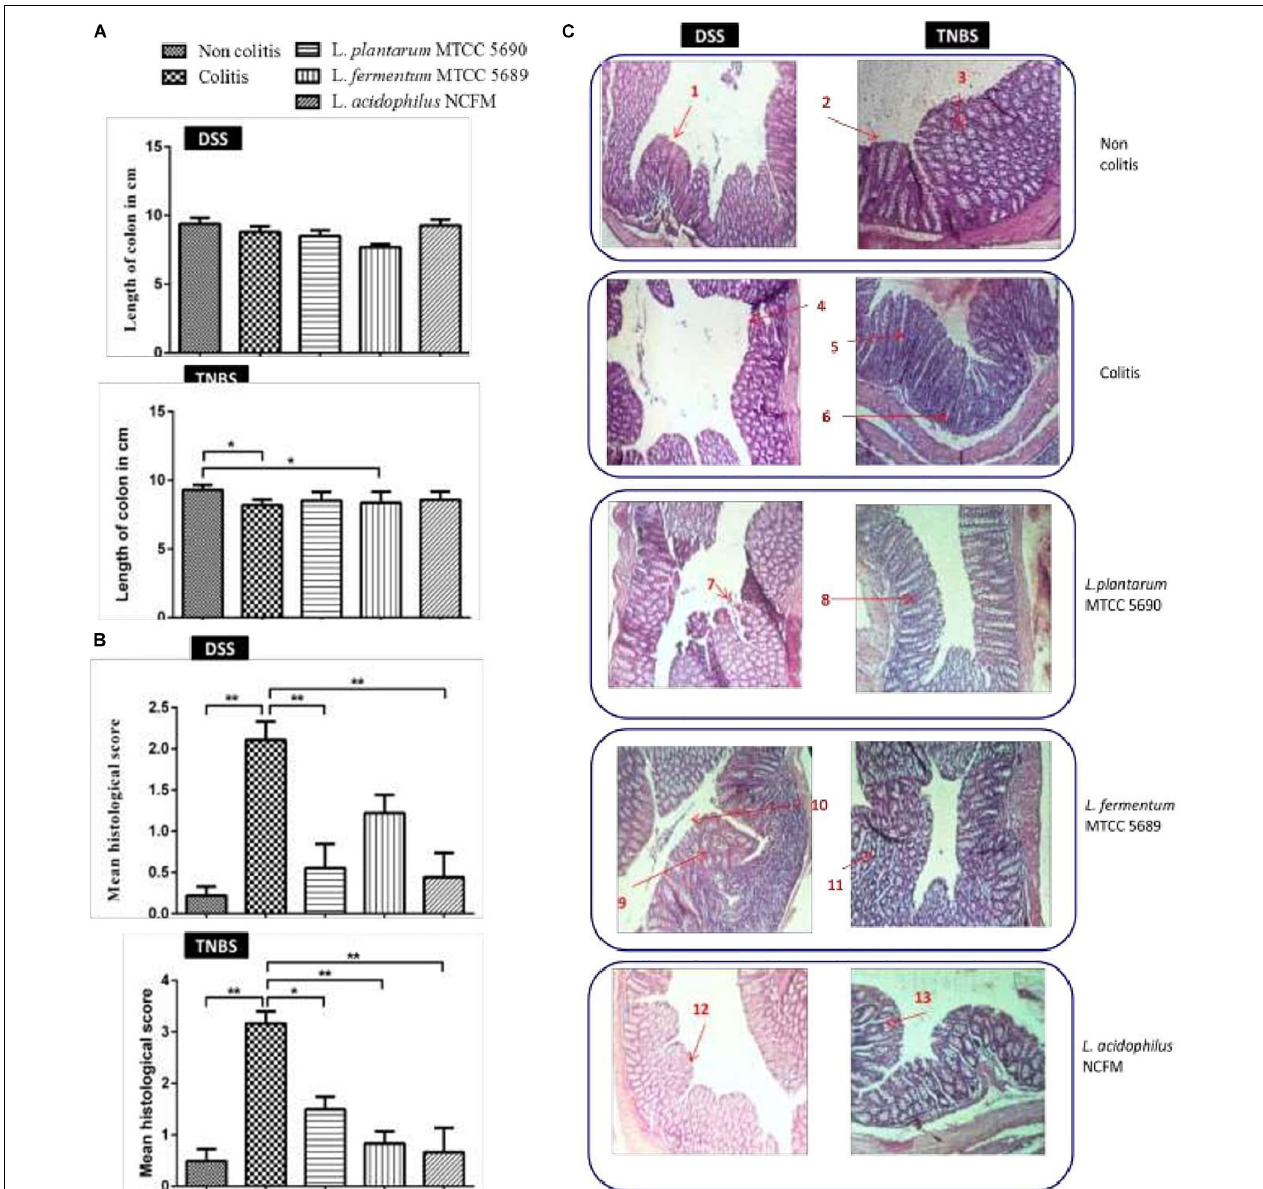
FIGURE 3 | (A) Changes in mean colon length of the different mice groups; (B) Histopathology-based colitis scores of different mice groups; (C) Gross morphology of the colons of mice from different groups used to measure severity of disease ( n = 8); 1, Intact surface epithelium; 2, Intact crypts; 3, Preserved goblet cells; 4, Erosion of surface epithelium; 5, Infiltration of lamina propria; 6, Crypt abscess; 7, Mild erosion of surface epithelium; 8, Mild loss of goblet cells; 9, Crypt abscess; 10, Mild erosion of surface epithelium; 11, Moderate loss of goblet cells with shortened crypts; 12, Normal colonic mucosa and surface epithelium; 13, Crypt branching with mild loss of goblet cells. * P < 0.05; ** P <